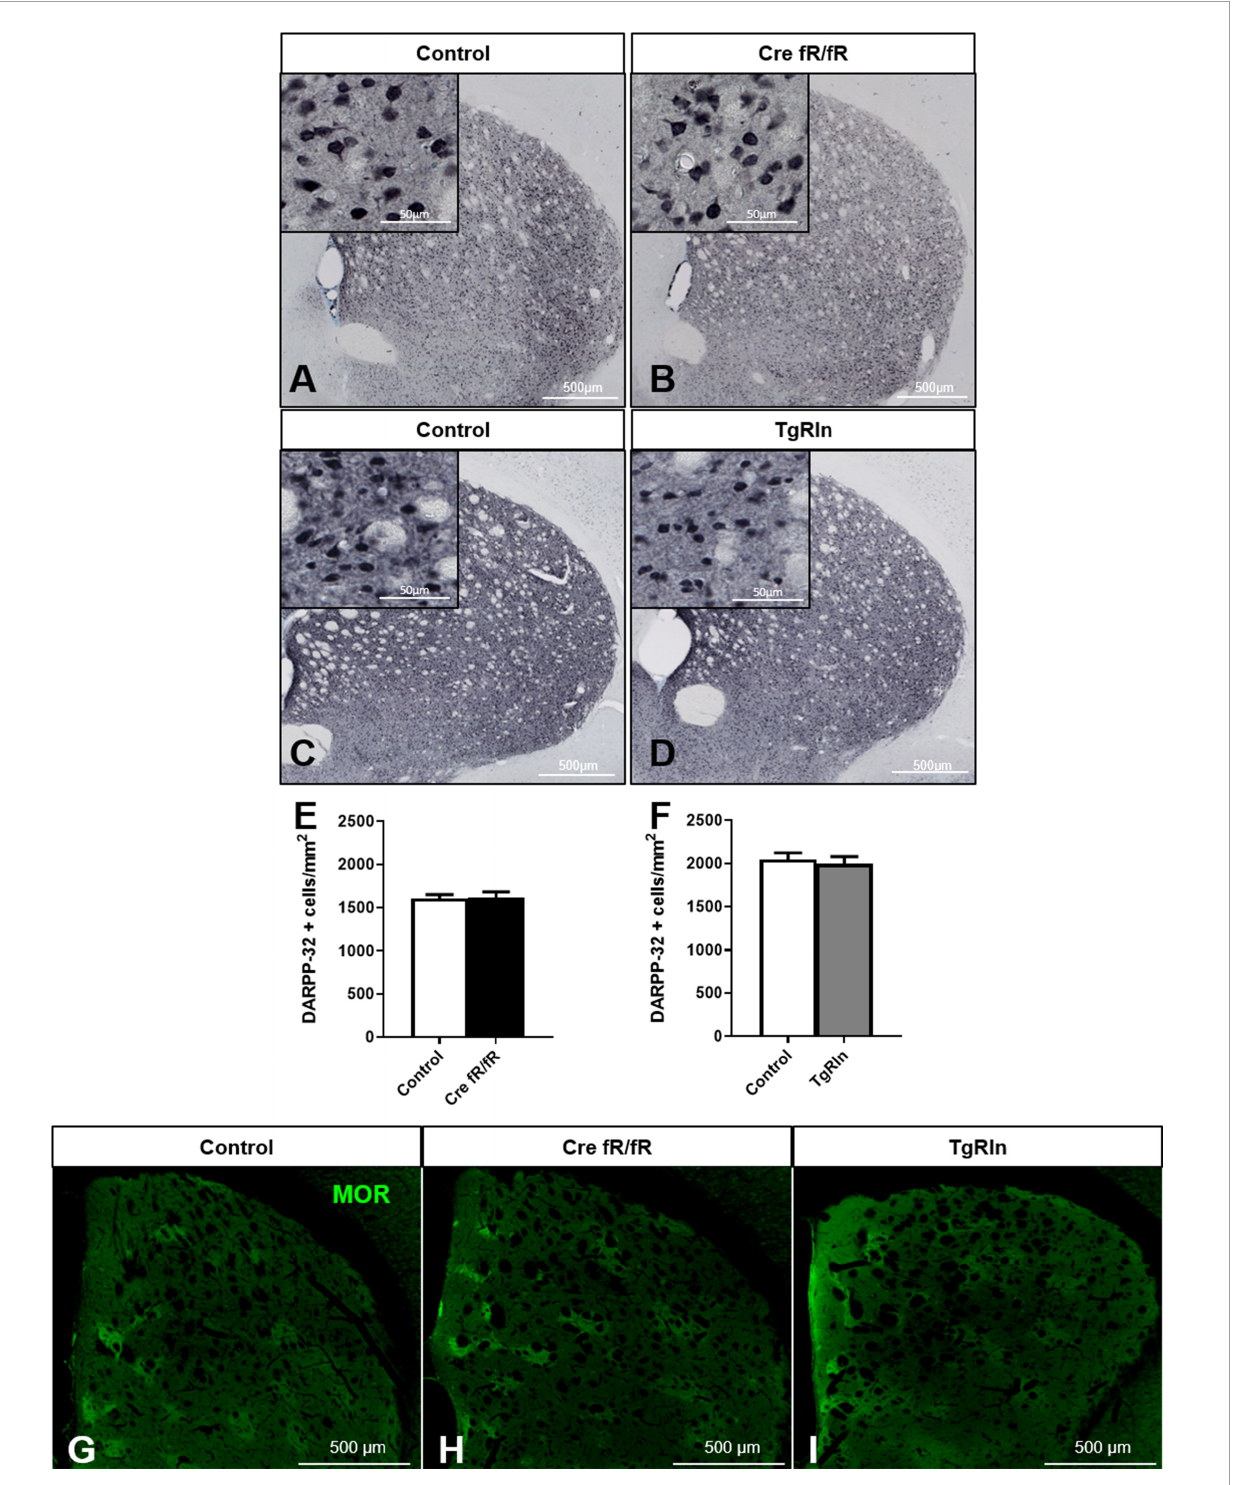
FIGURE2 Striatal MSNs density and organization is not affected by Reelin levels. (A–D) Representative images of DARPP-32 immunohistochemistry (striatal MSNs) in coronal sections of control and Cre fR/fR (A,B) and control and TgRln (C,D) striatum (respective controls as in Figure 1 ). (E,F) Quantification of DARPP-32-positive cell density shows no alterations of striatal MSNs neither in Cre fR/fR ( n = 5–6) (E) nor in TgRln ( n = 6) (F) mice. (G–I) Immunofluorescence for µ -opioid receptor (MOR) in coronal sections of control (G) , Cre fR/fR (H) , and TgRln (I) striatum showing a similar organization of striatal patches in all the models. Scale bar: (A–D) , 500 µ m; high magnification insets 50 µ m; (G–I) , 500 µ m. Statistical analysis was performed using Student’s t-test. Data are represented as means ±